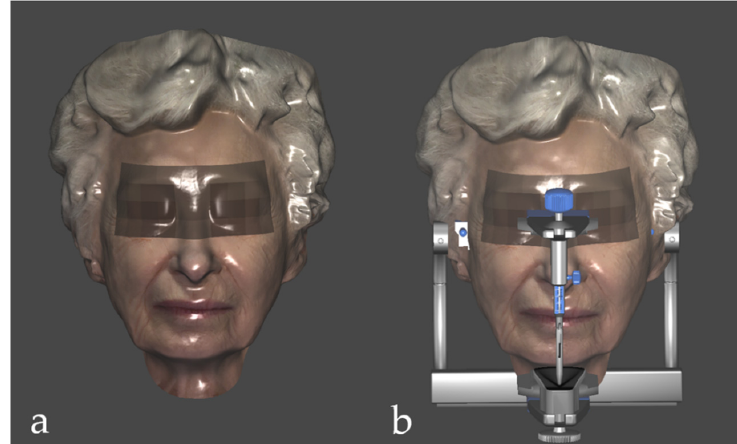
Figure 2. ( a ) 3D face scan ( b ) 3D face scan with articulator.